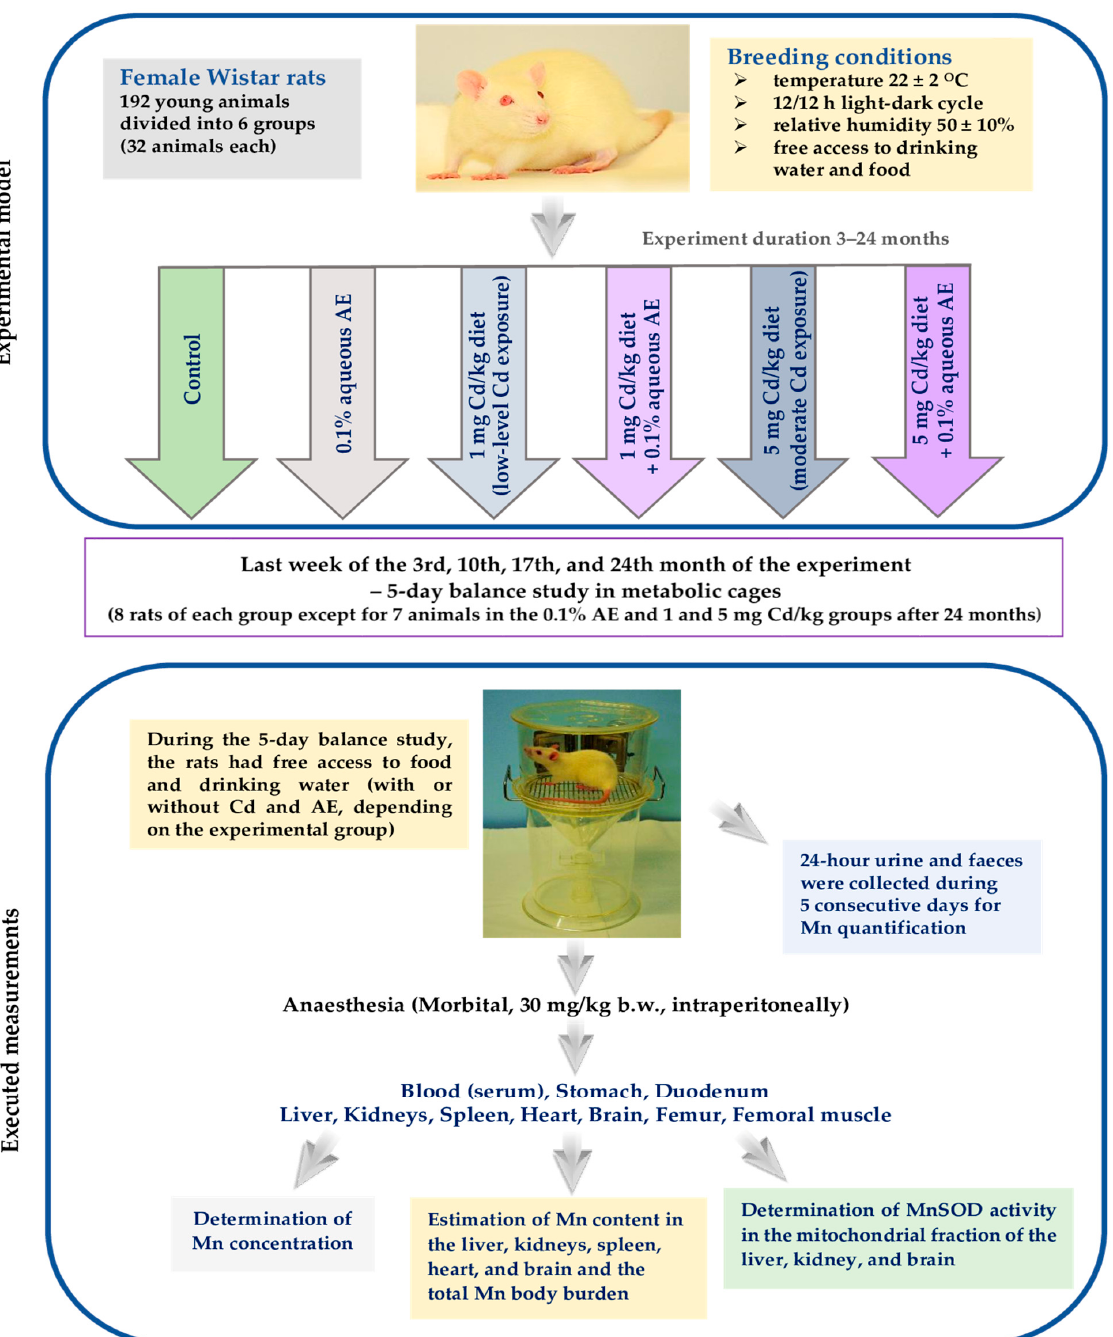
Figure 1. Schematic representation of the experimental model used in the present study and